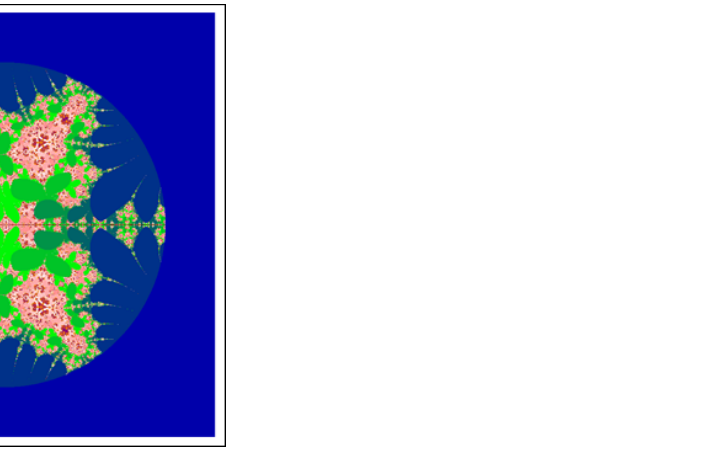
Figure 12. J-set via F-iterative scheme for sin ( z 3 ) + 1.09 with image visual time = 119.03 s.